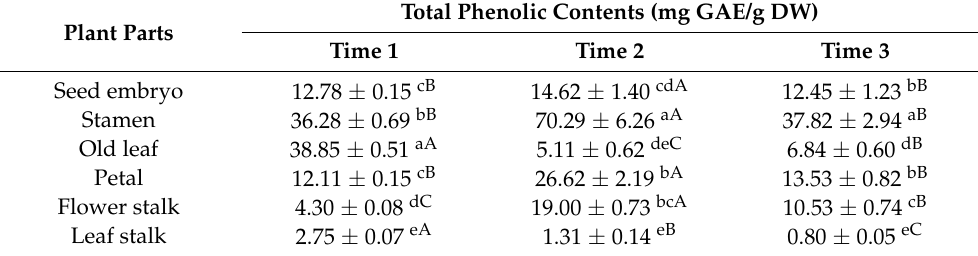
Table 2. Total phenolic contents (TPCs) of different sacred lotus parts collected from different time periods.